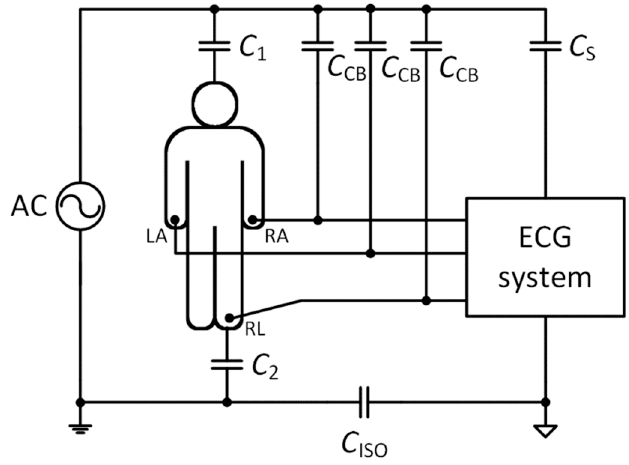
Figure 1. Block diagram of the power-line interference in the three-electrode electrocardiogram (ECG) acquisition system (inspired by [11]).